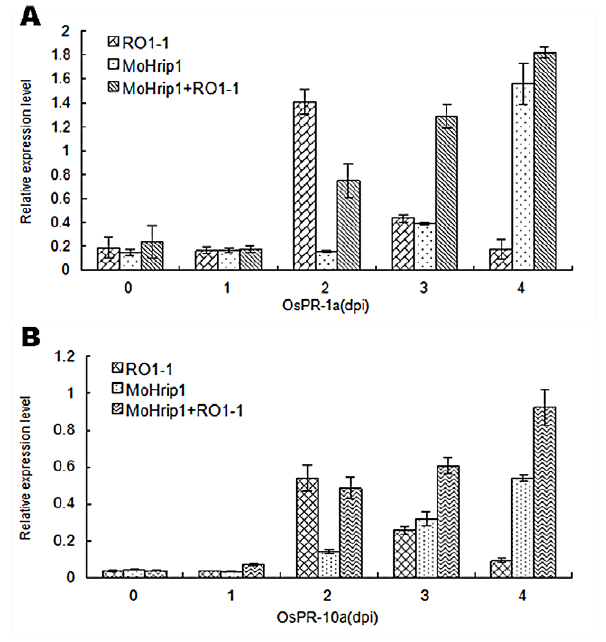
Figure 8. Defense-related gene expression induced by MoH- rip1 in rice leaves. PR genes were induced and their expression persisted for days in M. oryzae strain RO1-1-treated plants and in MoHrip1-pretreated plants that were not exposed to M. oryzae strain RO1-1. In contrast, the expression of PR genes was induced after 2 days of treatment and declined thereafter in the RO1-1-treated samples. The error bars represent 6 SD of the mean. Essentially identical results were obtained in three independent experiments. A . Expression of OsPR-1a induced by MoHrip1 in rice leaves, B . Expression of OsPR-10a induced by MoHrip1 in rice